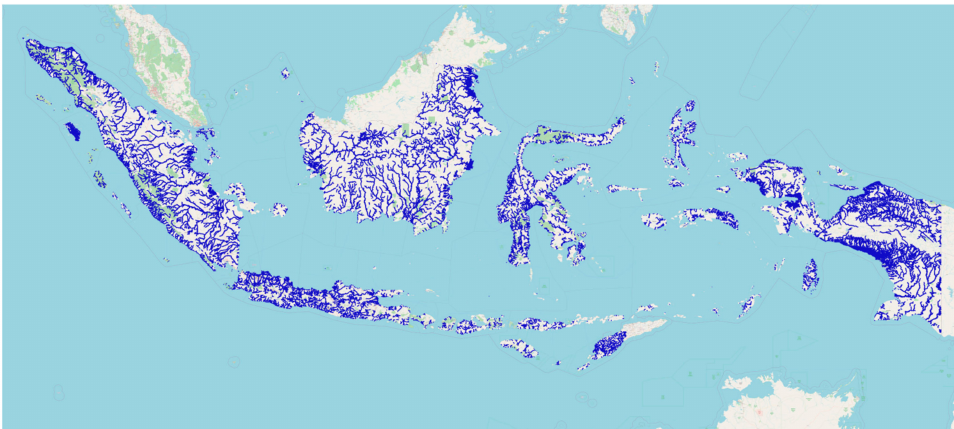
Figure 6. Map of major rivers in Indonesia. Map generated using QGIS software [27] and original data from the Indonesian Geospatial Information Agency [28].